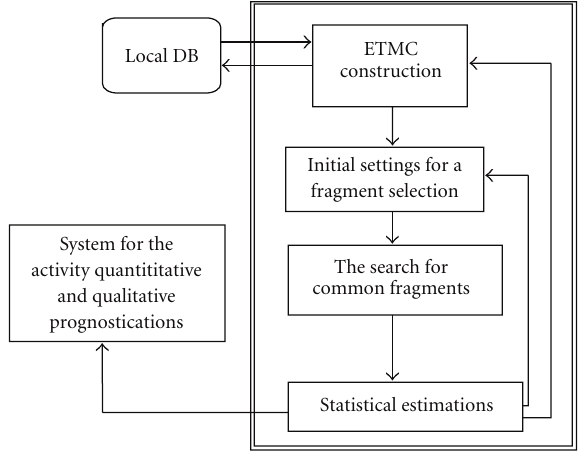
Figure 2: Common scheme of the